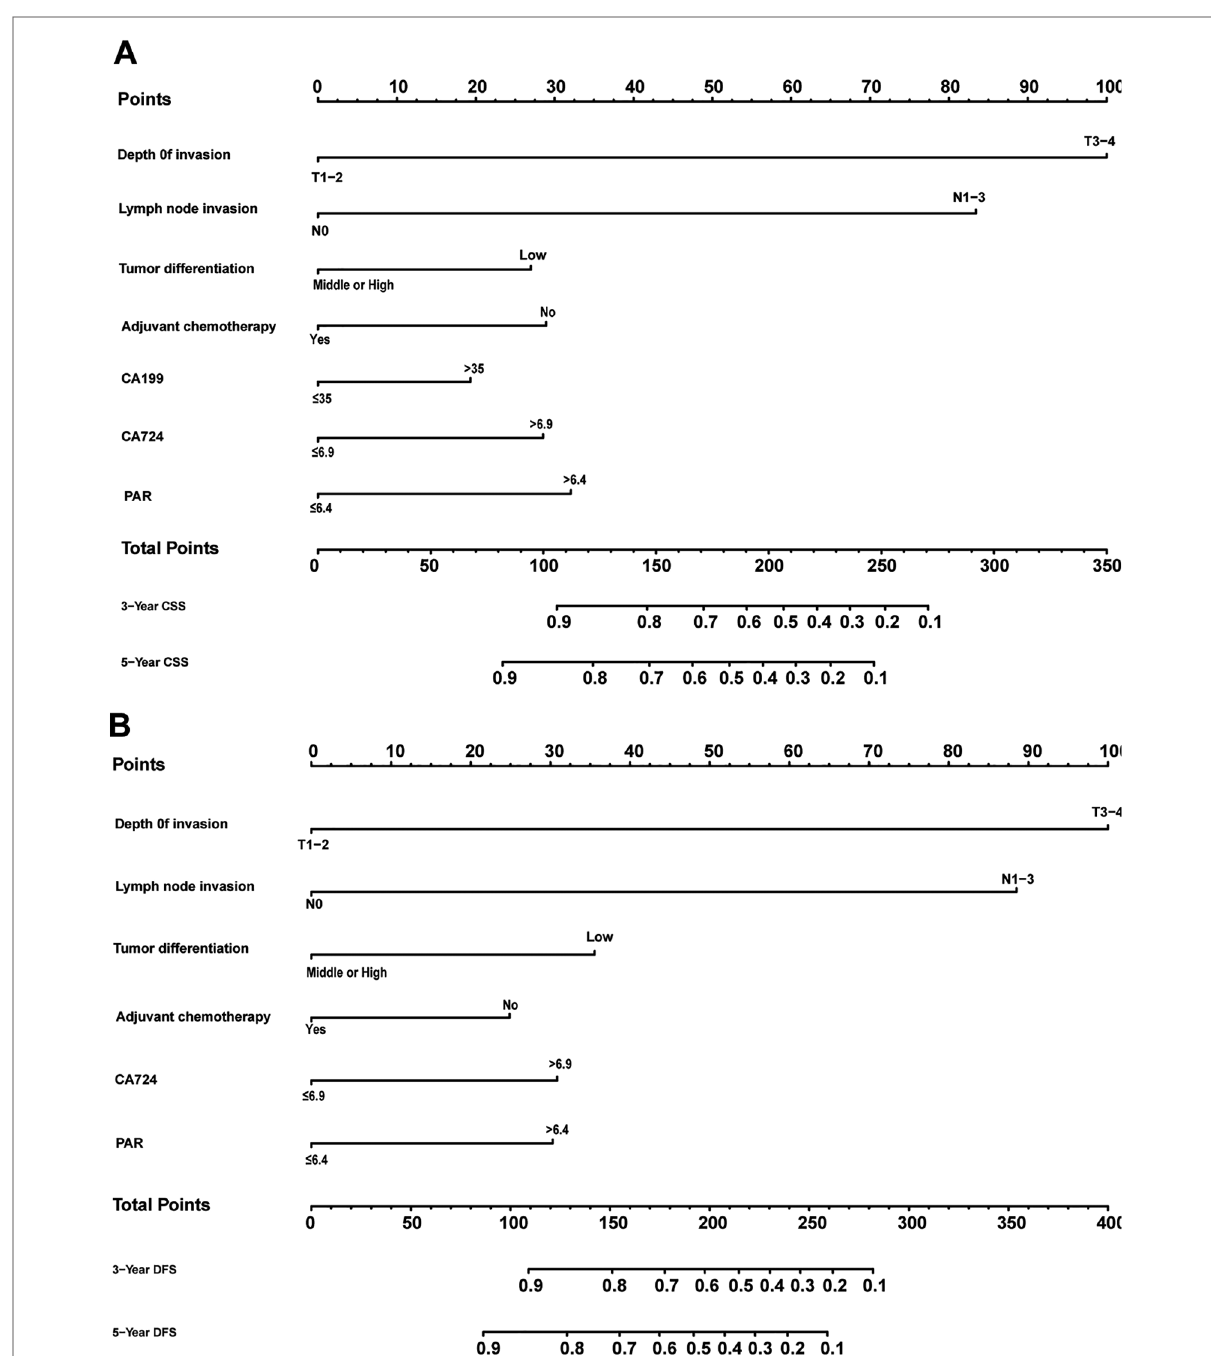
FIGURE 1 Nomogram predicting cancer-speci fi c survival ( A ) and disease-free survival ( B ) of patients with stage II/III gastric adenocarcinoma who underwent